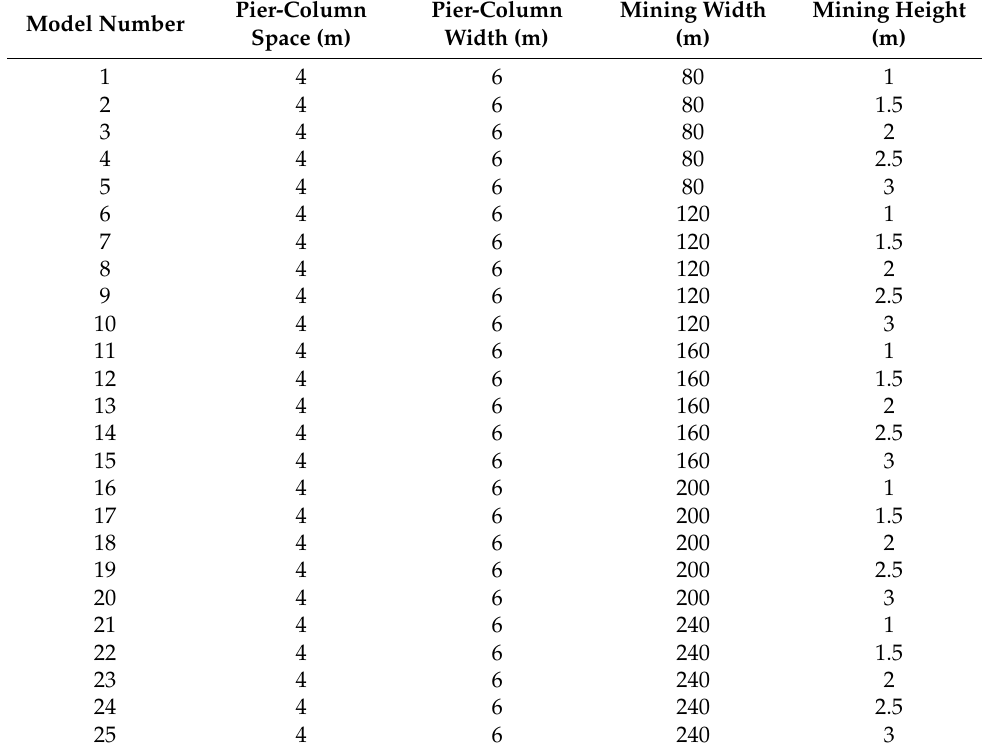
Table 2. Numerical simulation